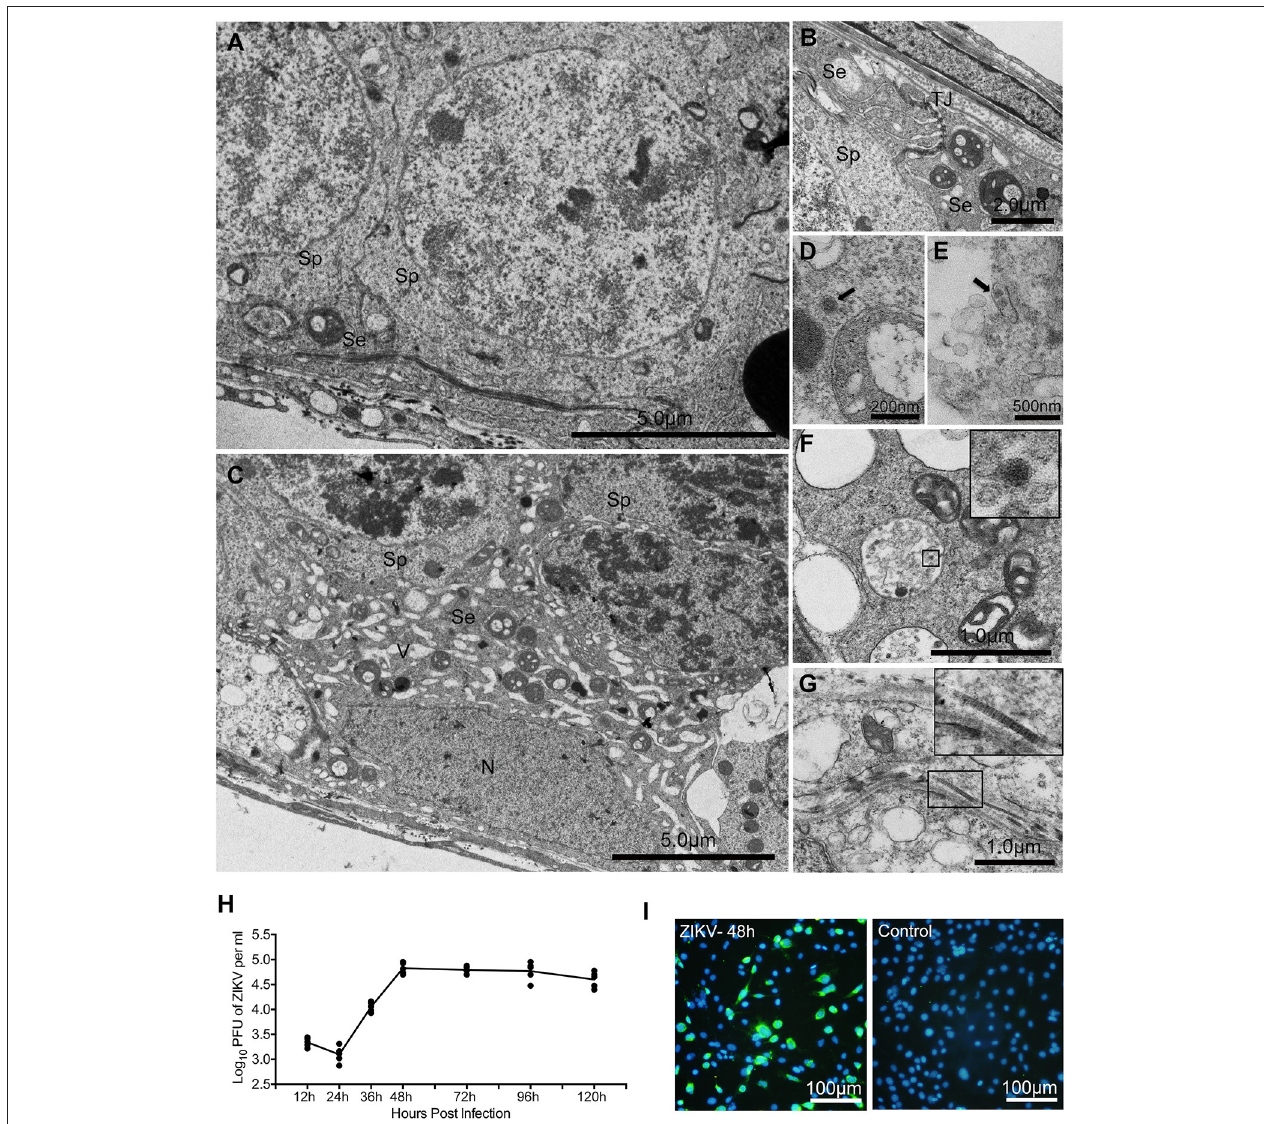
FIGURE 6 | The ultrastructure morphological changes of testes from mice with or without ZIKV infection at 5dpi under transmission electronic microscopy and replication of ZIKV in sertoli cell line. (A) Normal sertoli cell. (B) Tight junctions of normal sertoli cells. (C) Vacuoles change in ZIKV-infected sertoli cells at 5 dpi. (D–F) Viral particles in the cytoplasm of infected sertoli cells at 5 dpi (arrows or in frame). (G) Collagen fibers in seminiferous tubules. (H) Sertoli cell line was infected by ZIKV (multiplicity of infection, MOI = 1). Culture supernatant was harvested at different time point as indicated for determining viral titers by plaque assay ( n = 5). (I) ZIKV antigen were detected by immunofluoresecent staining with anti-ZIKV polyclonal antibody at 2 dpi. Se, sertoli cells; Sp, spermatocytes; N, nucleus; TJ, tight junctions; V, vacuoles; CF, collagen